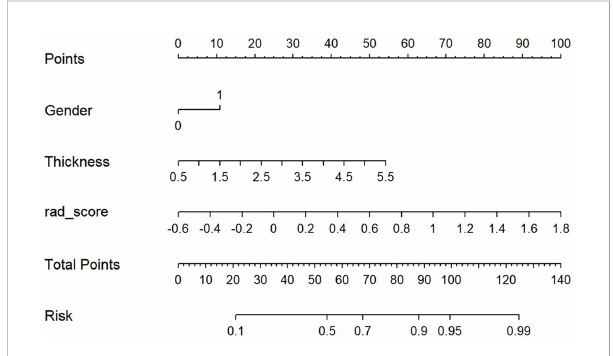
FIGURE 3 Predictive nomogram combined Rad-score, sex, and esophageal cancer